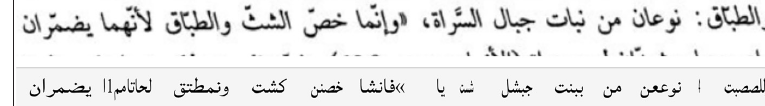
Figure 6: Example of poor transcription of italicized passage in figure